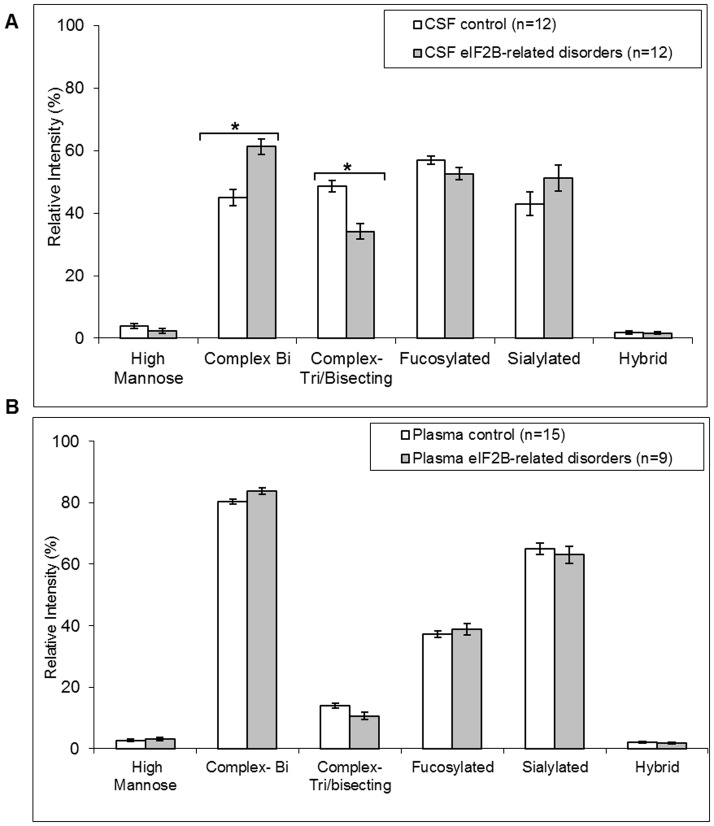
Comparison of relative intensities (%, +/−SEM) of N-glycan types derived from CSF (A) or plasma (B) from healthy individuals (controls) and affected eIF2B-mutated patients.* Statistically significant with ANOVA test p values<0.0001.